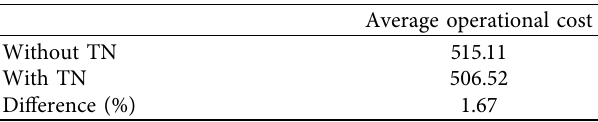
Table 10: Comparison of the average operational costs of 2EVRP- TN-OD and 2EVRP-OD